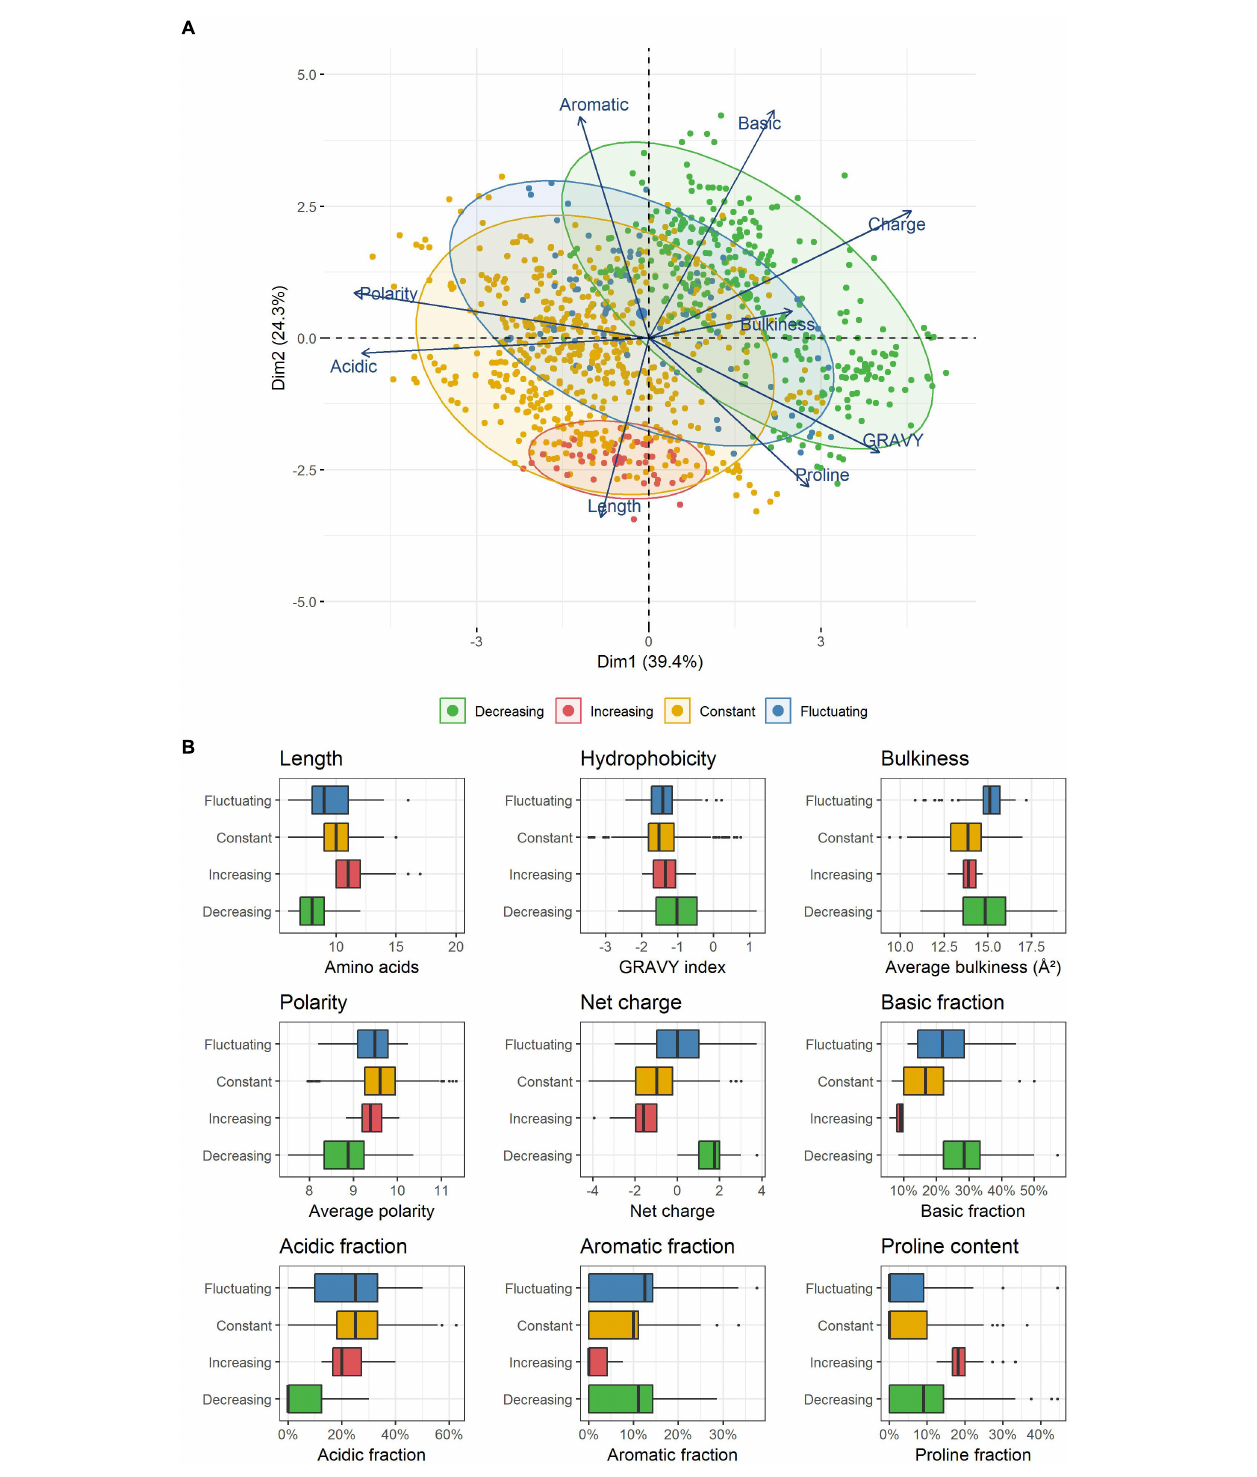
FIGURE 3 | (A) PCA representation of peptides enclosed within the different kinetic profiles observed. Each point represents a unique peptide. (B) Physicochemical properties of the peptides constituting the four kinetic profiles identified. Each box plot displays the distribution of the values taken by all unique peptides included in each kinetic profile. The boxes display the range between the first and third quartile of each distribution, and the central bold lines their median value. Individual points are peptides considered as outliers.